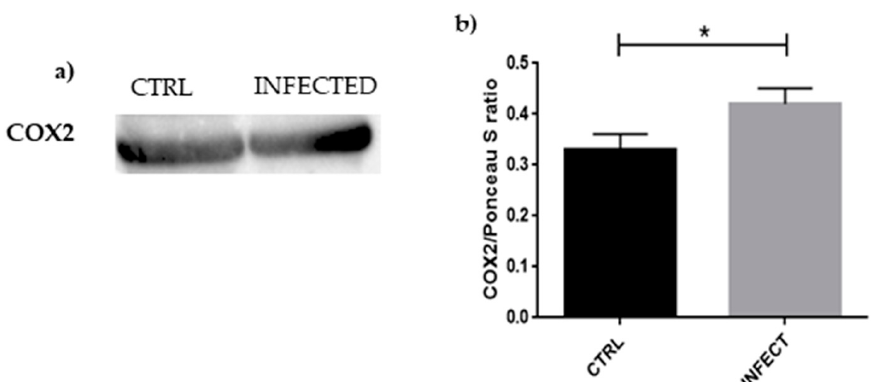
Figure 4. ( a ) Evidence of significant increase in COX2 expression in HCN-2 culture medium after SARS-CoV-2 infection, suggesting inflammation in the infected cells; ( b ) densitometric analysis of COX2, * p < 0.05.